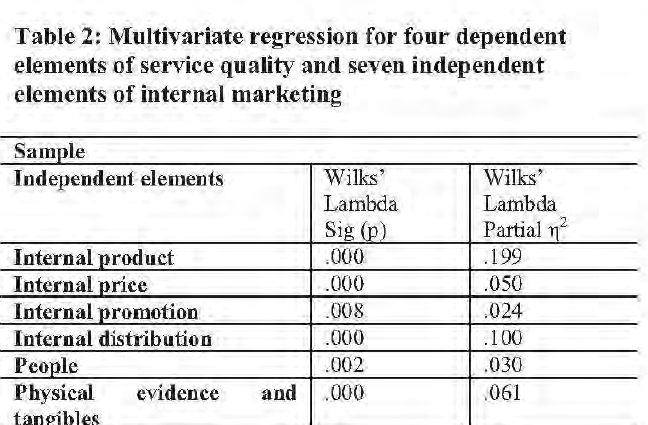
Table 2: Multivariate regression for four dependent elements of service quality and seven independent elements of internal marketing